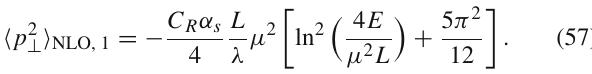
Fig. 16 (Top) Comparison between the full result for the momentum broadening from radiative emissions from Eq. (13c) (dots) and the lead- ing energy behavior from Eq. (57) for L = 5 fm and μ = 0 . 5 GeV. (Bottom) Ratio of the full numerical result Eq. (13c) to the asymptotic analytic result Eq. (57) for L = 5 fm and μ = 0 . 5